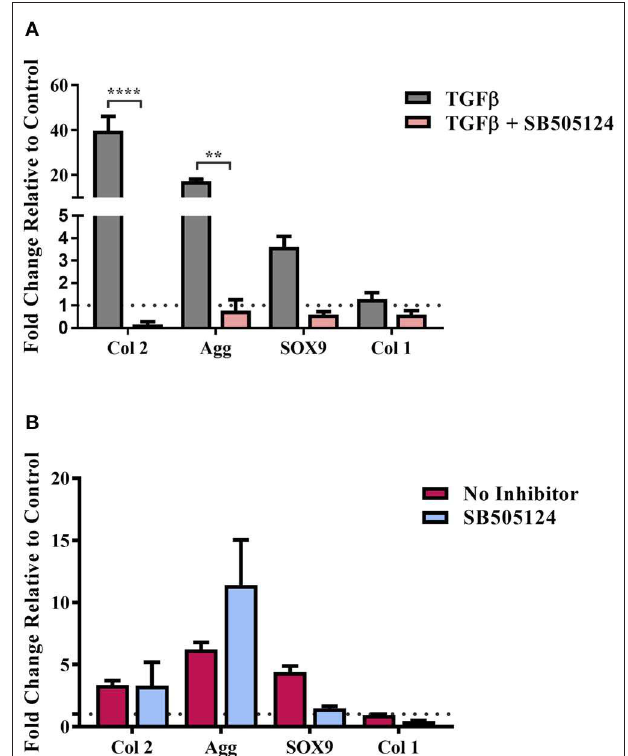
FIGURE 4 | TGF β -driven Smad2/3 phosphorylation and stem cell chondrogenesis. hMSCs were cultured on (A) Tissue cultured plastic in chondrogenic media supplemented with transforming growth factor- β (TGF β ) and (B) composite cellulose:silk 75:25 substrates in stem cell